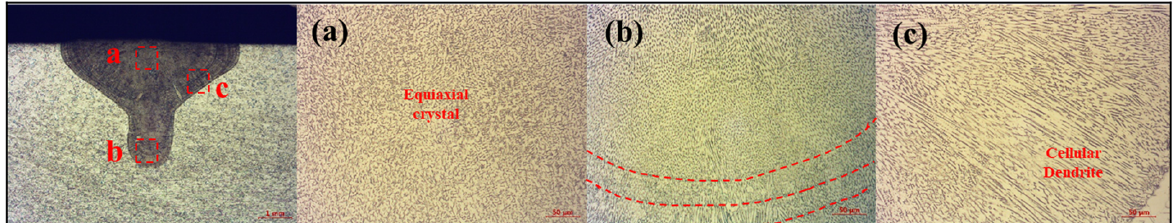
Figure 4. Optical micrographs showing microstructure in weld area cross section for specimen prepared via in ‐ air laser welding with laser power of 2 kW. The three right ‐ most panels show expanded views of areas outlined by dashed red lines in the left ‐ most panel. ( a ) enlarged a, ( b ) enlarged b, ( c ) enlarged c.